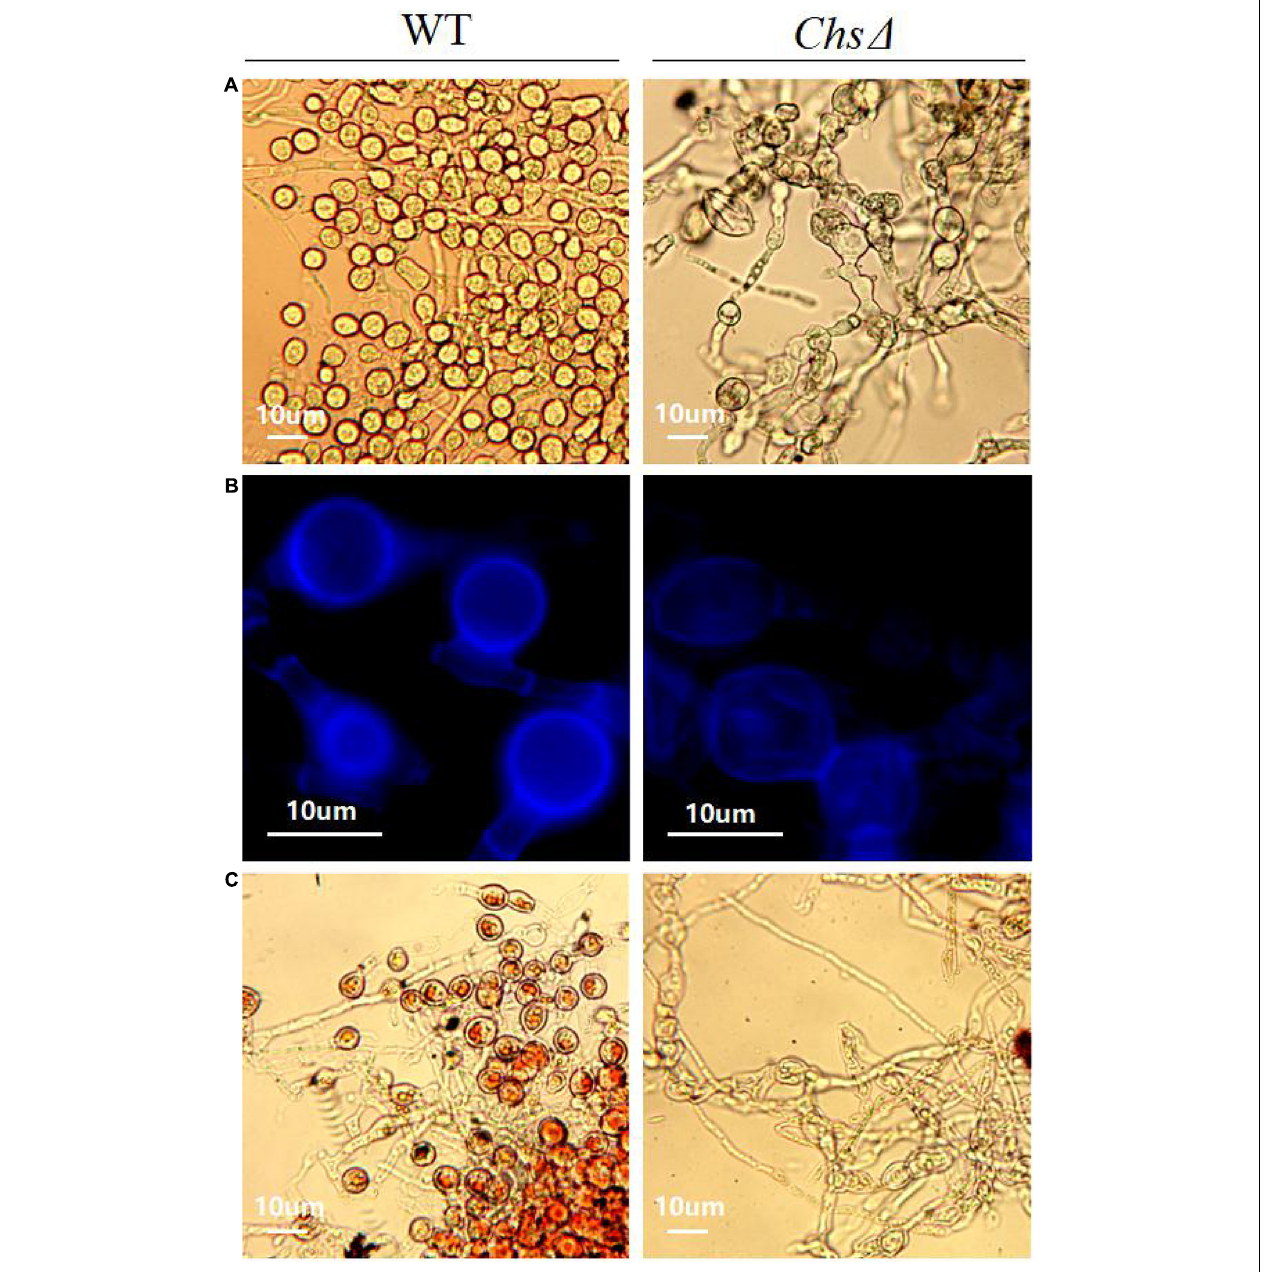
FIGURE 8 | Effect of chitin synthase gene (TRIVIDRAFT_90152) deletion on CF in T. virens GV29-8. (A) The chlamydospores formed by the wild-type T. virens GV29-8 and chitin synthase gene (TRIVIDRAFT_90152) deletion mutant ( Chs (cid:49) ). (B) Chitin staining of wild-type and Chs (cid:49) mutant strains. (C) Oil red O staining of wild type and Chs (cid:49) mutant